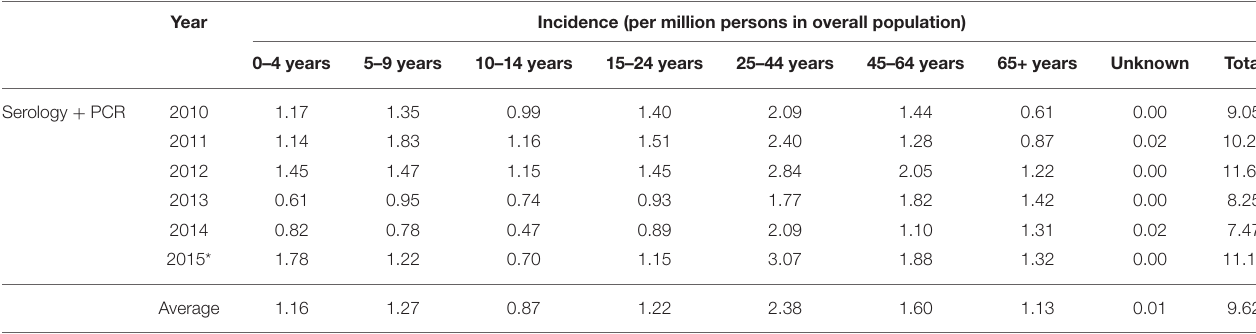
TABLE 1 | Incidence of M. pneumoniae positive laboratory reports per million